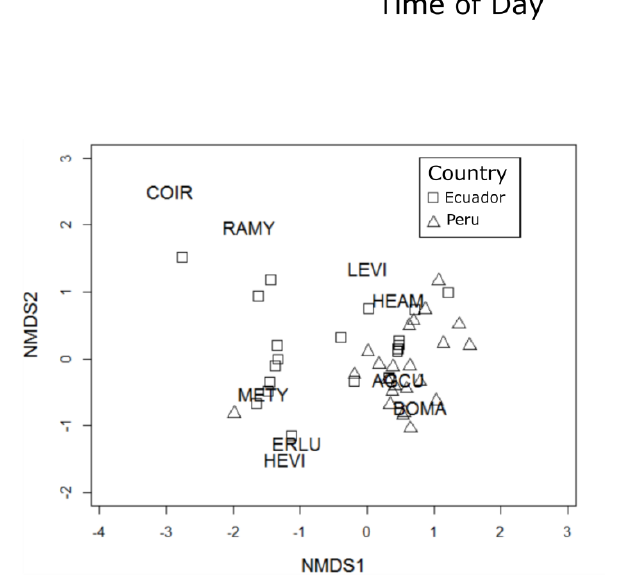
F IGURE 3. A comparison of nectar secretion rates of Oreocallis